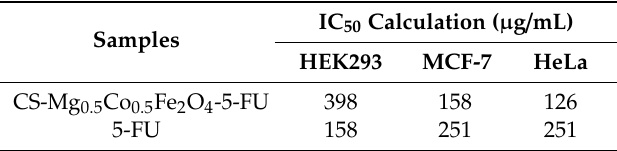
Figure 5. SRB cell viability assay in human cell lines ( A ) HEK293, ( B ) MCF-7, and ( C ) HeLa. (** p < 0.01, * p < 0.05) was considered statistically significant and the mean data is represented as means ± SD ( n = 3). Table 3. IC 50 values of free 5-FU and 5-FU-loaded nanocomposites in HEK293, MCF-7 and HeLa cells for the SRB assay.